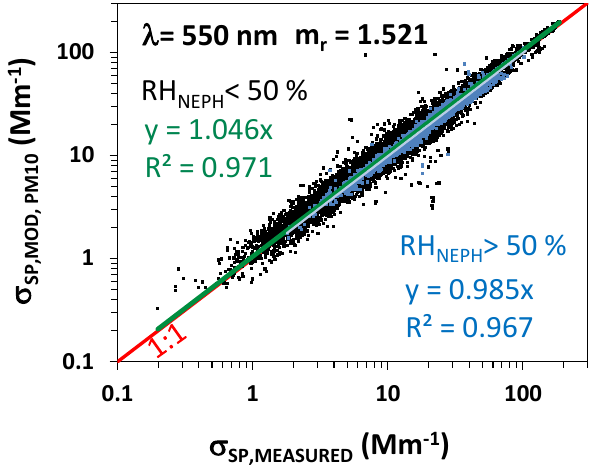
Fig. 9. Measured and modelled ( D p < 10µm) σ SP at 550nm by assuming purely scattering aerosol and using the refractive index of ammonium sulfate ( m = 1 . 521 + 0 i ) for the whole measurement period and for all particle